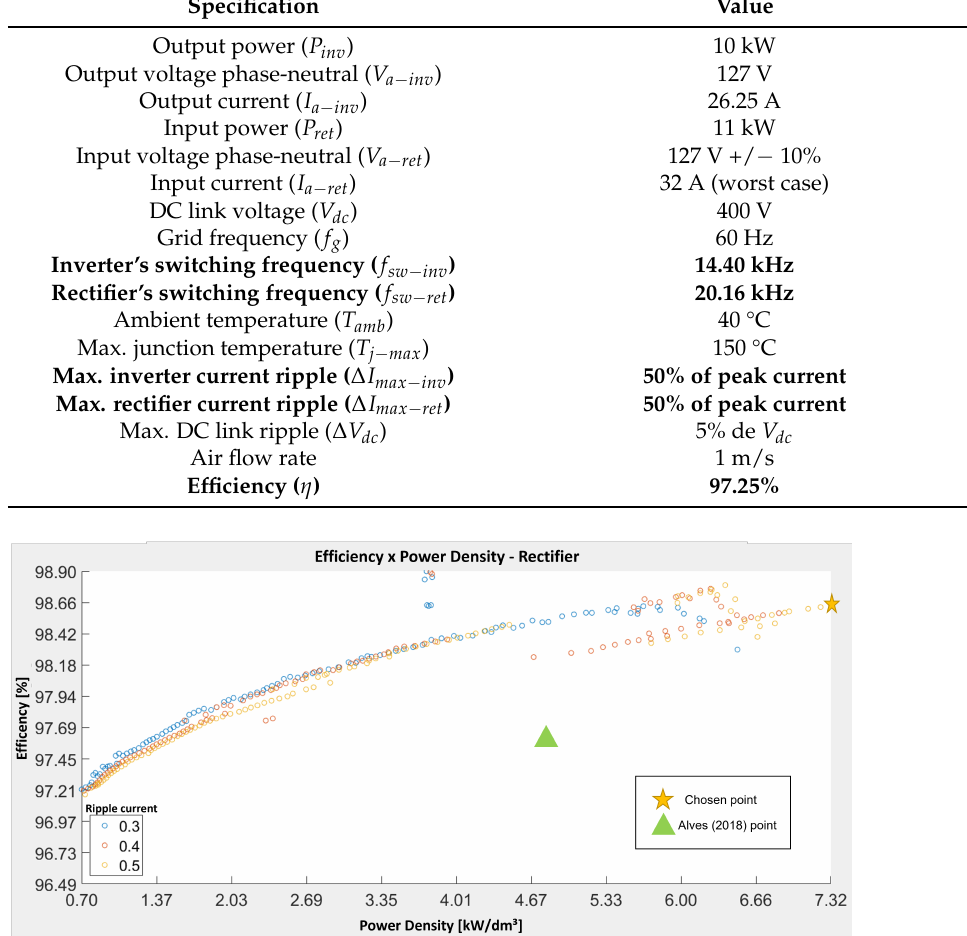
Figure 3. Pareto front ( ρ − η ) for the